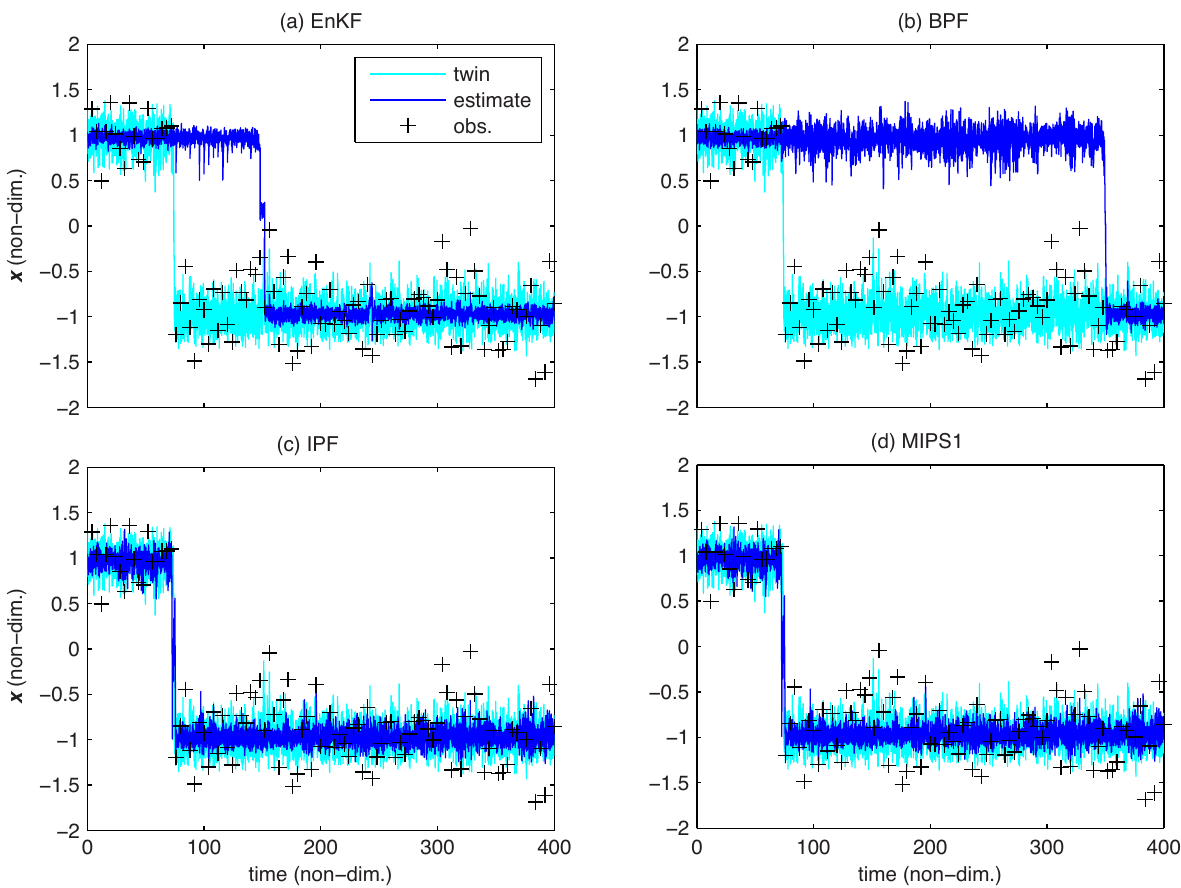
Fig. 4. Comparison of the estimates with 10 particles of the (a) ensemble Kalman filter, (b) bootstrap particle filter, (c) implicit particle filter and (d) mixture-based implicit particle smoother with N m = 1 .